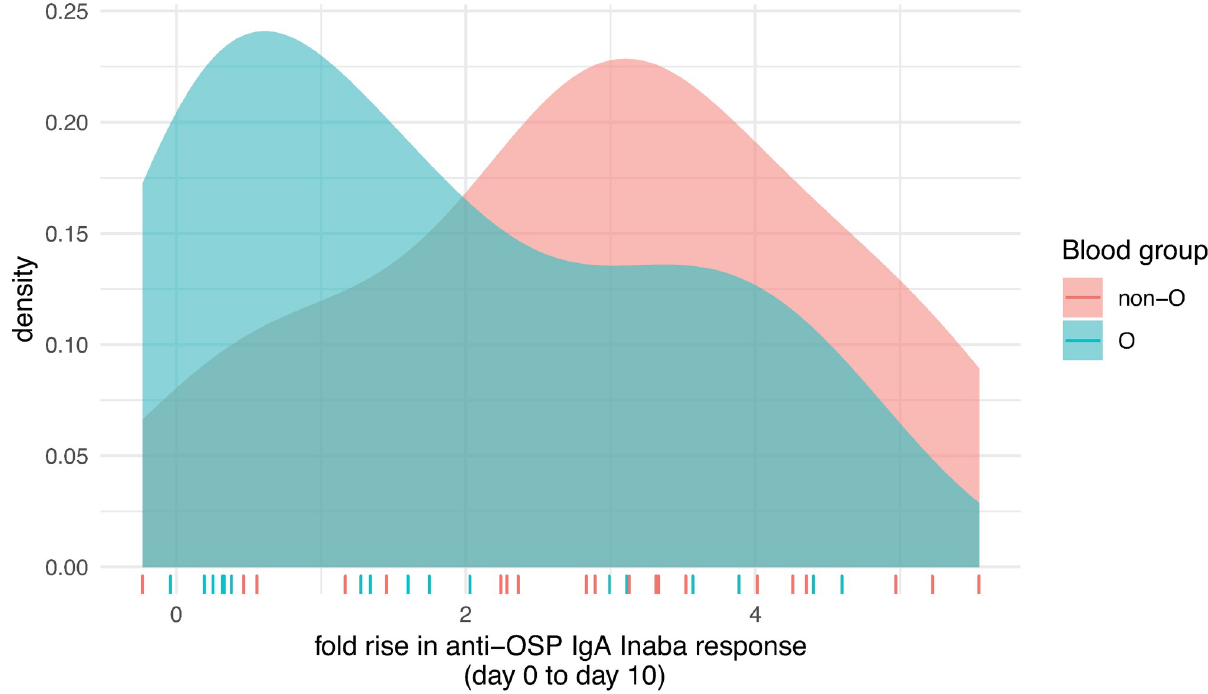
Fig 4. Fold-changes of anti-Inaba OSP IgA responses by O versus non-O blood group status. Distribution of fold-changes of anti-Inaba OSP IgA responses from pre-infection to day 10 following experimental infection of North American volunteers with V . cholerae O1 by O versus non-O blood group status. Colored ticks on x-axis illustrate the values of the fold-change for each participant.